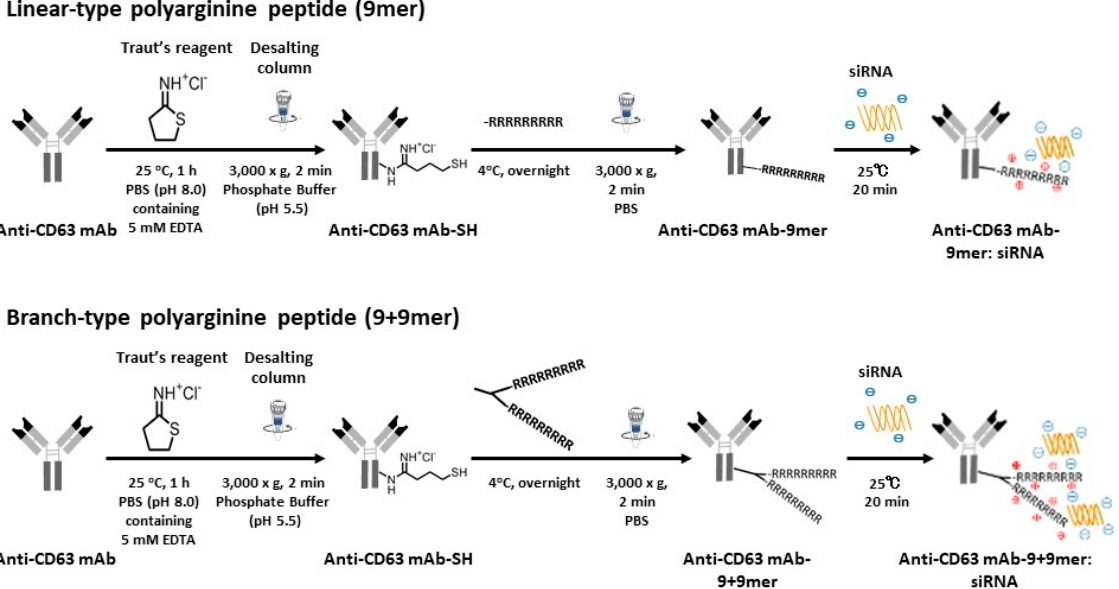
Figure 2. Schematic illustrating anti-CD63 mAb-conjugated siRNA complex synthesis. The procedure was conducted as described in the “Materials and methods” section. Schematic diagrams show linker-containing complex synthesis with linear arginine (9mer) (above) and branched arginine (9+9mer) (below).